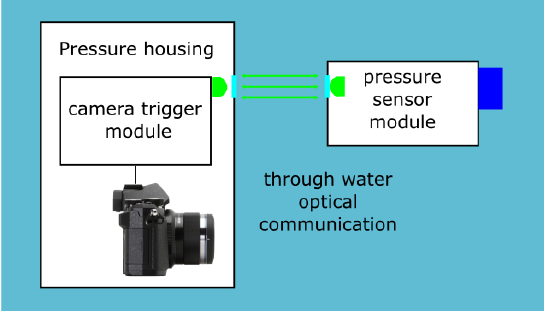
Figure 4 . High level architecture of the developed prototype for underwater pressure sensor